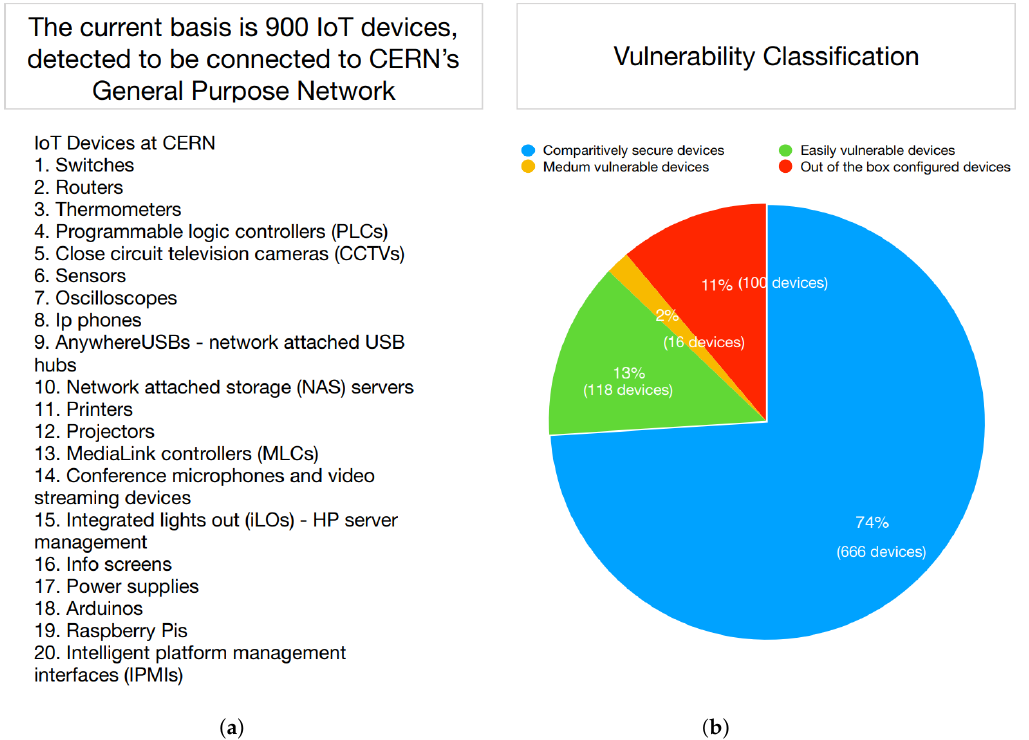
Figure 1. ( a ) Overview of Internet of Things (IoT) devices at the European Organization for Nuclear Research (CERN). ( b ) Vulnerability classification of Internet of Things(IoT) devices at the European Organization for Nuclear Research